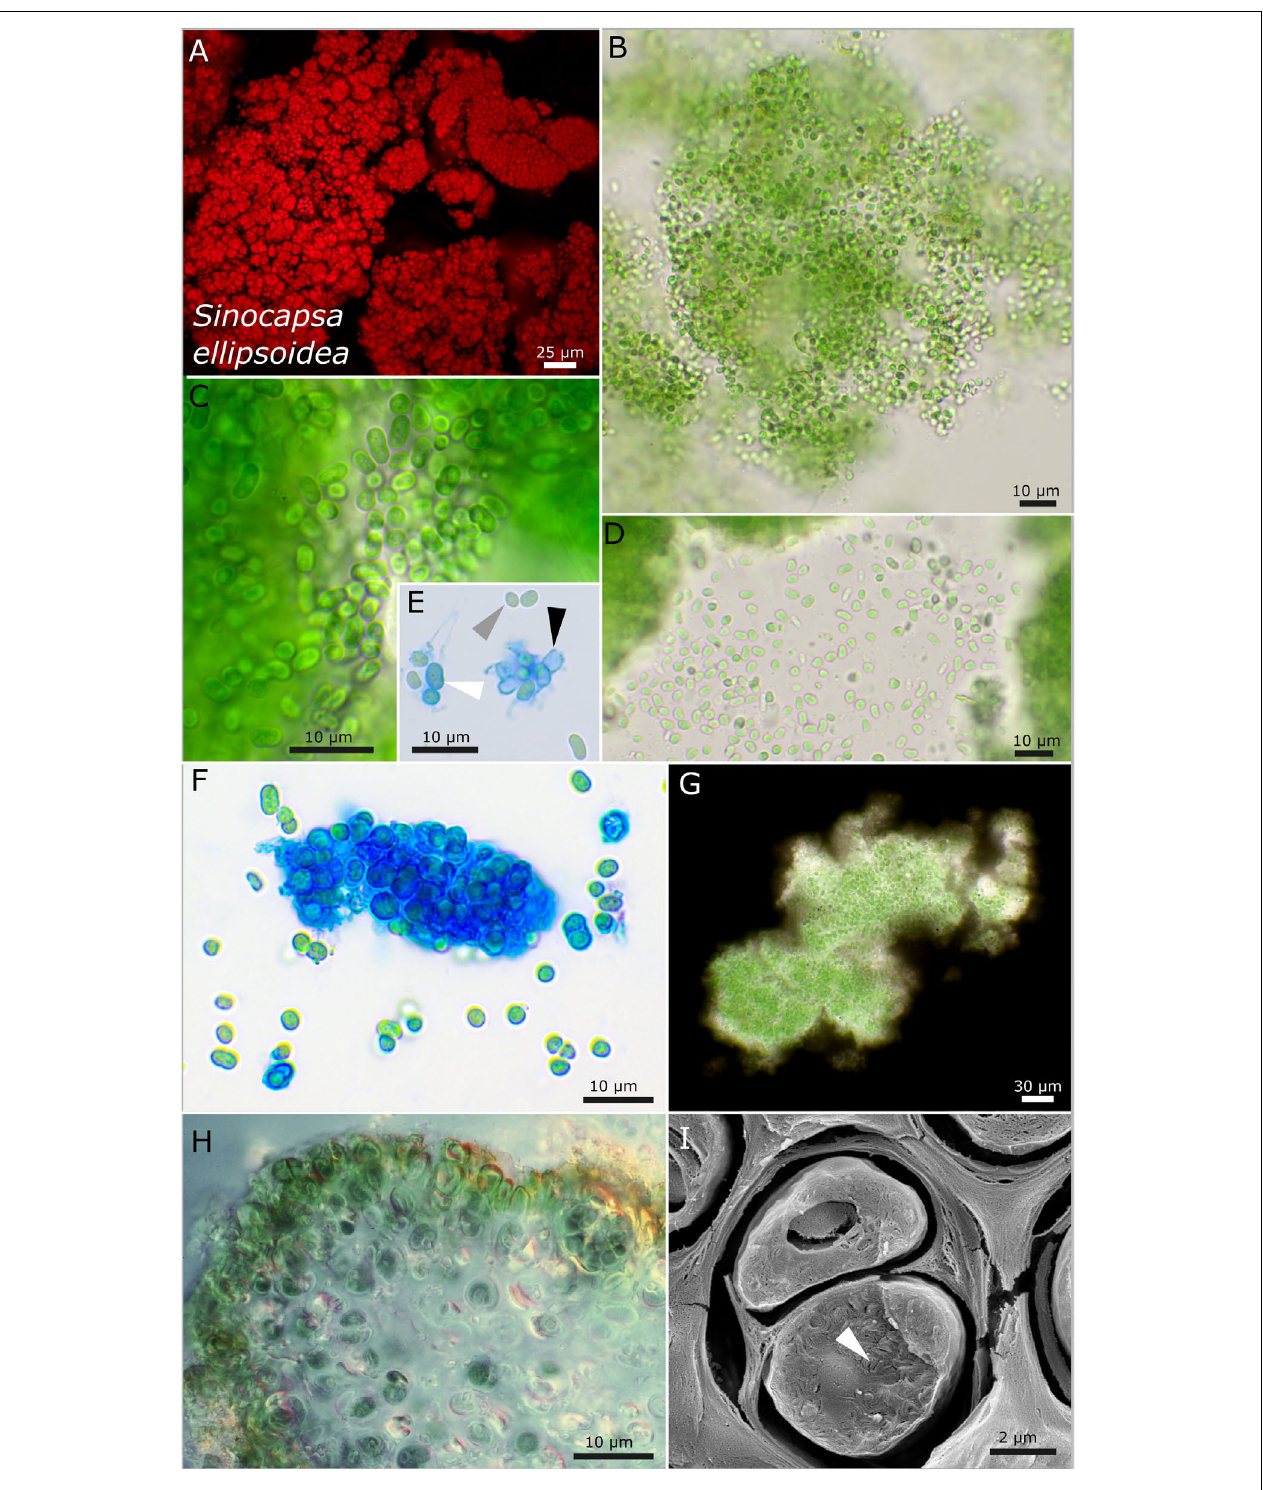
FIGURE 4 | Micrographs showing Sinocapsa ellipsoidea . (A) Autofluorescence image, (B–H) light microscopy, and (I) low-temperature scanning electron microscopy (SEM). (B) Overview image showing the diffluent character of larger colonies. (C,D) Released, unsheathed, ellipsoidal single cells. (E,F) ACN staining highlighting the capsule-like, firm sheath material [white arrow in (E) ], unsheathed cells [gray arrow in (E) ], and empty capsules [black arrow in (E) ]. (G) Indian ink staining visualizing the sheath matrix of larger colonies. (H) Cross-section through a thallus piece of Peccania cerebriformis showing the rounded cyanobacteria. (I) SEM image of two cut cells with their coiled thylakoid membranes (white arrow).